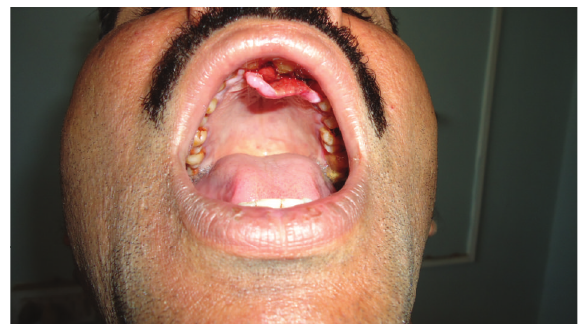
Figure 1: Exophytic gingival growth in the maxillary anterior palatal region.